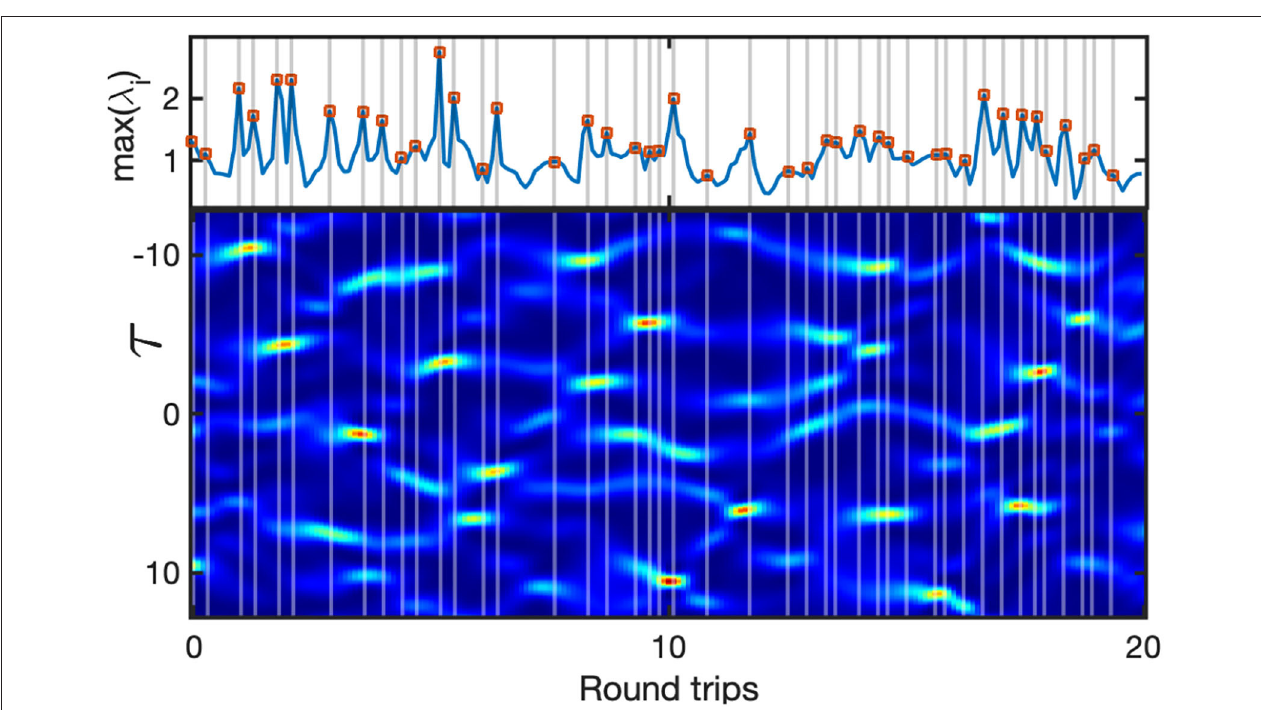
0.2, δ 1, and S 0.43. The blue line = = =